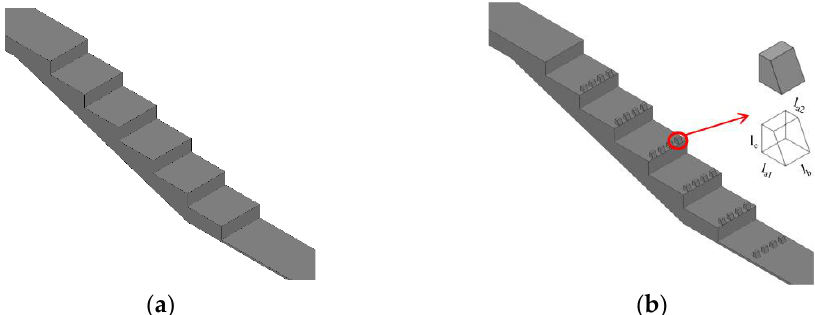
Figure 4. Schematic diagram of the experimental model arrangement: ( a ) Type I: traditional step energy dissipator; ( b ) Type II: trapezoidal energy dissipation baffle block-step combination energy dissipator.